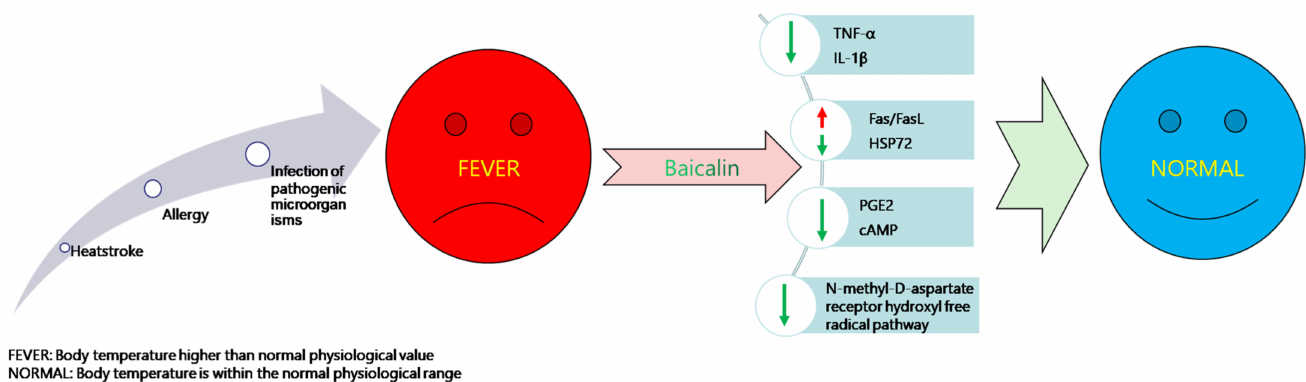
Figure 3. Schematic diagram of the antipyretic mechanism of baicalin. FEVER: Body temperature is higher than the normal physiological value. NORMAL: Body temperature is within the normal physiological